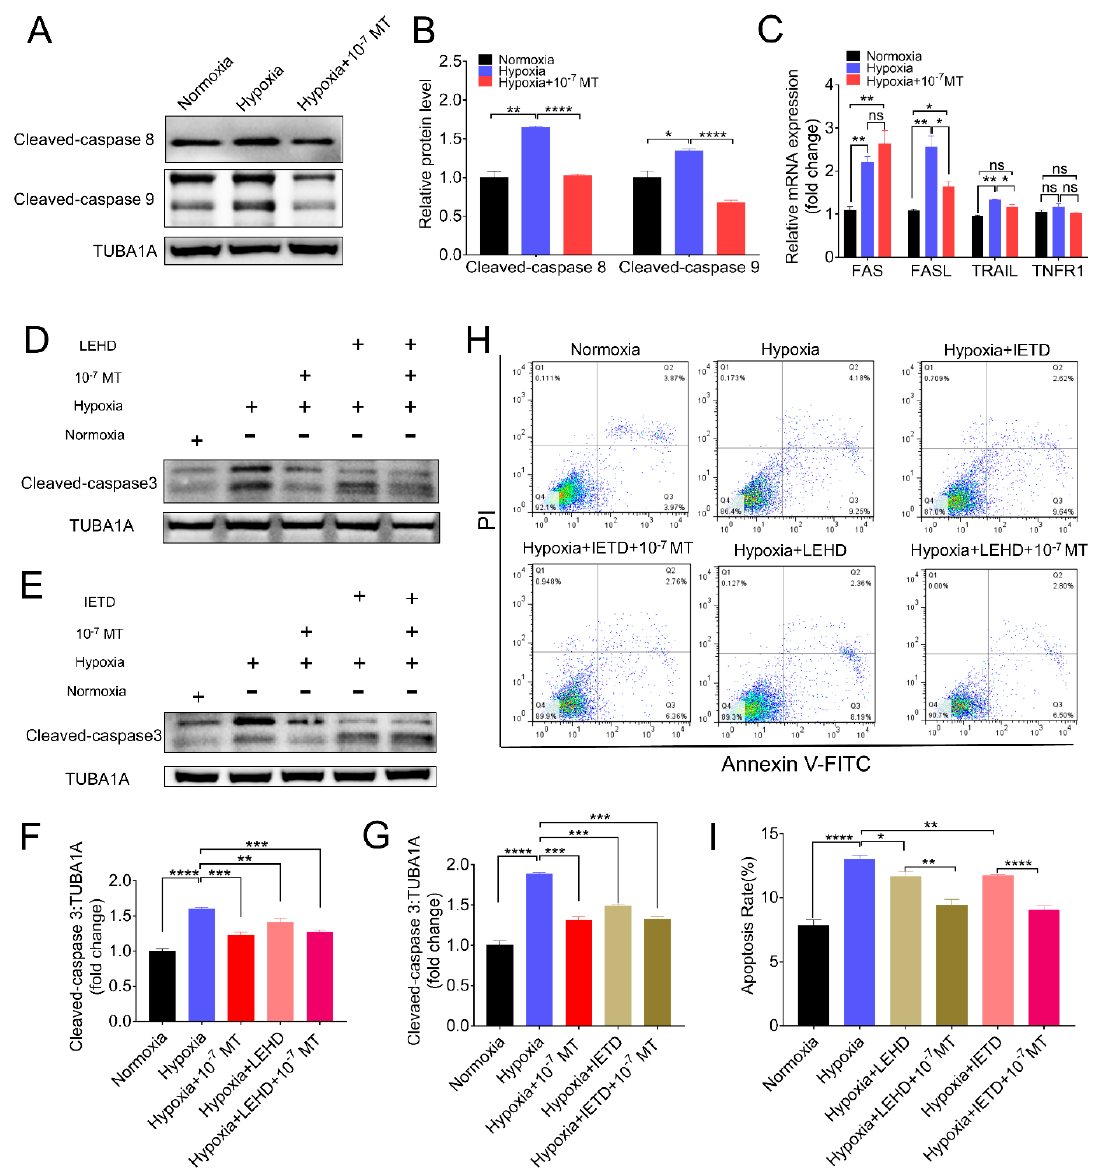
Figure 4. The suppression of caspase − 8 and caspase − 9 is required for MT-mediated GCs protection against hypoxia-induced apoptosis. ( A ) The level of cleaved caspase − 8 and cleaved caspase − 9 was determined by Western blotting in porcine GCs cultured in normoxia, hypoxia, and hypoxia plus 10 − 7 M MT. ( B ) Quantitative analysis of the level of cleaved caspase − 8 and cleaved caspase − 9. ( C ) The relative mRNA expression level of the receptor and ligand of extrinsic apoptotic pathways. ( D , E ) The level of cleaved caspase − 3 was determined by Western blotting in GCs cultured in normoxia and hypoxia in the presence of MT, LEHD (Z-LEHD-FMK, caspase − 9 inhibitor), or IETD (Z-IETD-FMK, caspase − 8 inhibitor). ( F , G ) Quantitative analysis of cleaved caspase − 3 level. ( H ) Flow cytometry analysis of the apoptosis rates in porcine GCs treated with IETD. ( I ) Statistics of the apoptosis of porcine GCs. * p < 0.05 was considered significant; ** p < 0.01 was considered highly significant; *** p < 0.001 was considered very significant; **** p < 0.0001 was considered extremely significant; ns p > 0.05 was considered no